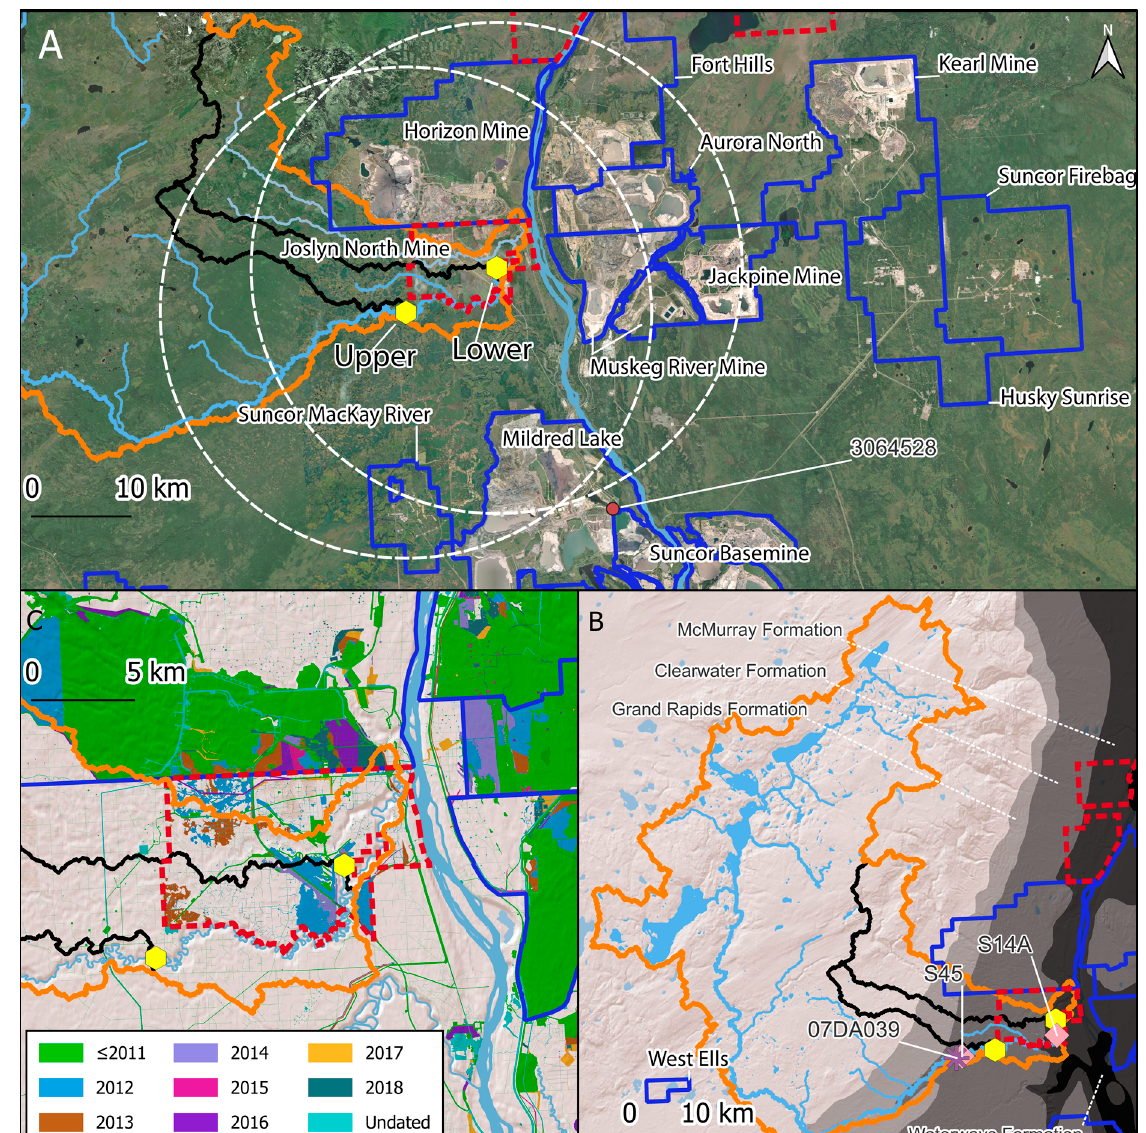
Figure 1. Area of study in Canada’s Oil Sands Region; ( A ): fishing locations in the Ells basin (Upper and Lower), project boundaries of facilities operating in 2018 (blue outlines; Fort Hills began